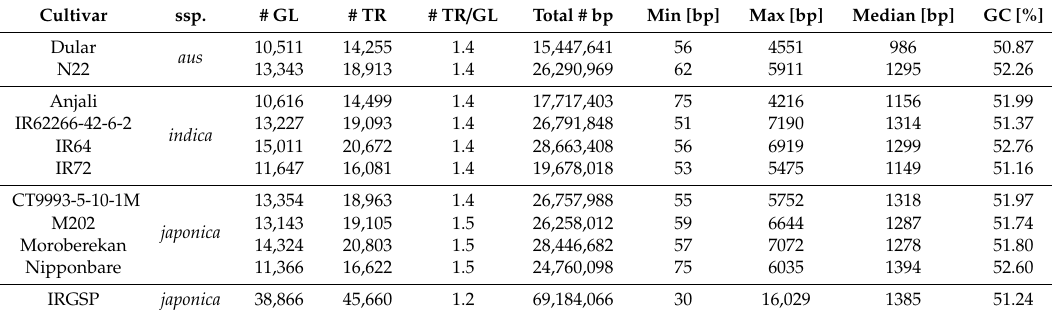
Table 4. Summary of reconstructed transcriptomes including the Nipponbare reference